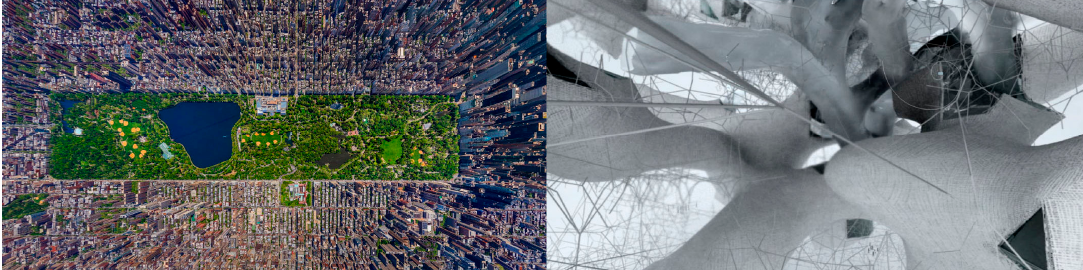
Figure 2. Images deeply rooted in a real space (geographic maps and images of cities) and images in a necessarily imagined space (virtual and augmented reality, utopian cities or Piranesian